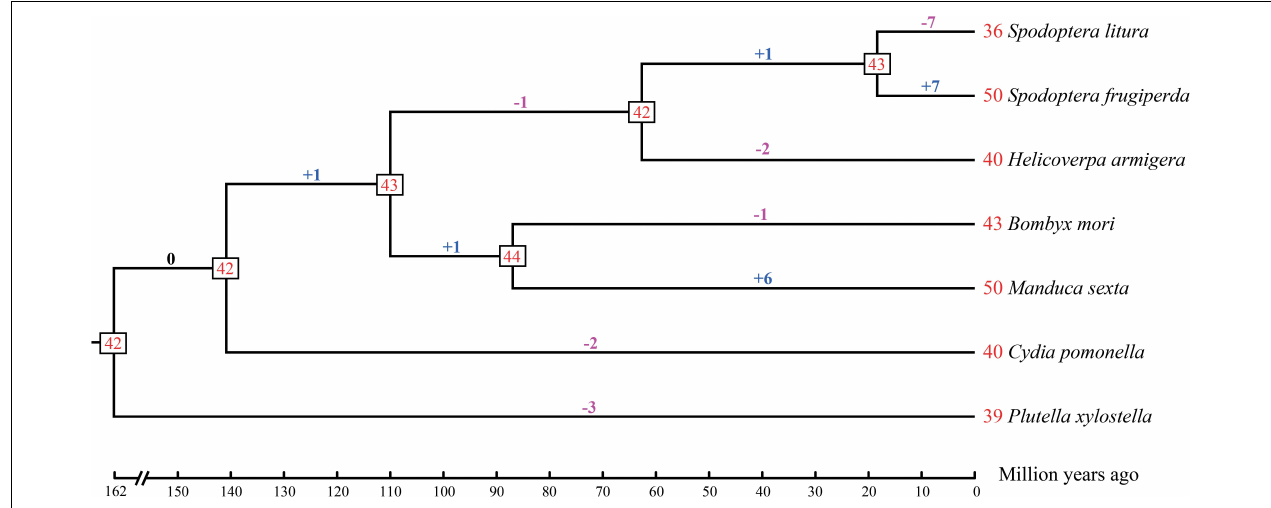
FIGURE 2 | Estimation of OBP gene gains and losses during the evolution of seven moth species. The phylogenetic tree with estimated divergence times (million year ago) was inferred by MCMCTree in PAML v4.9b. The numbers at the tree termini are the numbers of genes in each species, which we found in the literature: Spodoptera litura , Spodoptera frugiperda , Helicoverpa armigera , Manduca sexta , and Plutella xylostella , the numbers of OBP genes in Cydia pomonella were identified in this study, while the number of OBP genes in Bombyx mori was corrected by this study (see section “Materials and Methods”). The numbers at the tree nodes are the numbers of genes in their most recent common ancestors. The numbers of gene gains and losses are shown above the branches, where the symbol “+” represents gene gains while “-” represents gene losses. The numbers before each species represent the OBP genes of the specific moth.